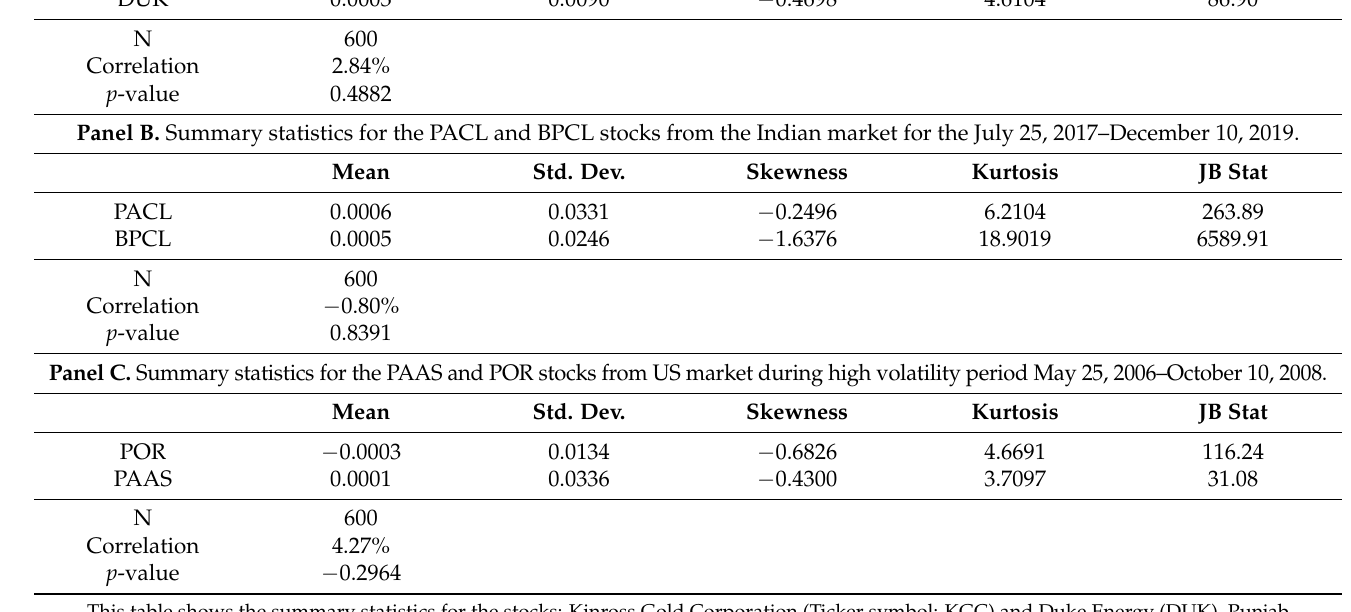
This table shows the summary statistics for the stocks: Kinross Gold Corporation (Ticker symbol: KGC) and Duke Energy (DUK), Punjab Alkalies and Chemicals Limited (PACL), and Bharat Petroleum Corporation Limited (BPCL) and Pan American Silver Corp (PAAS)